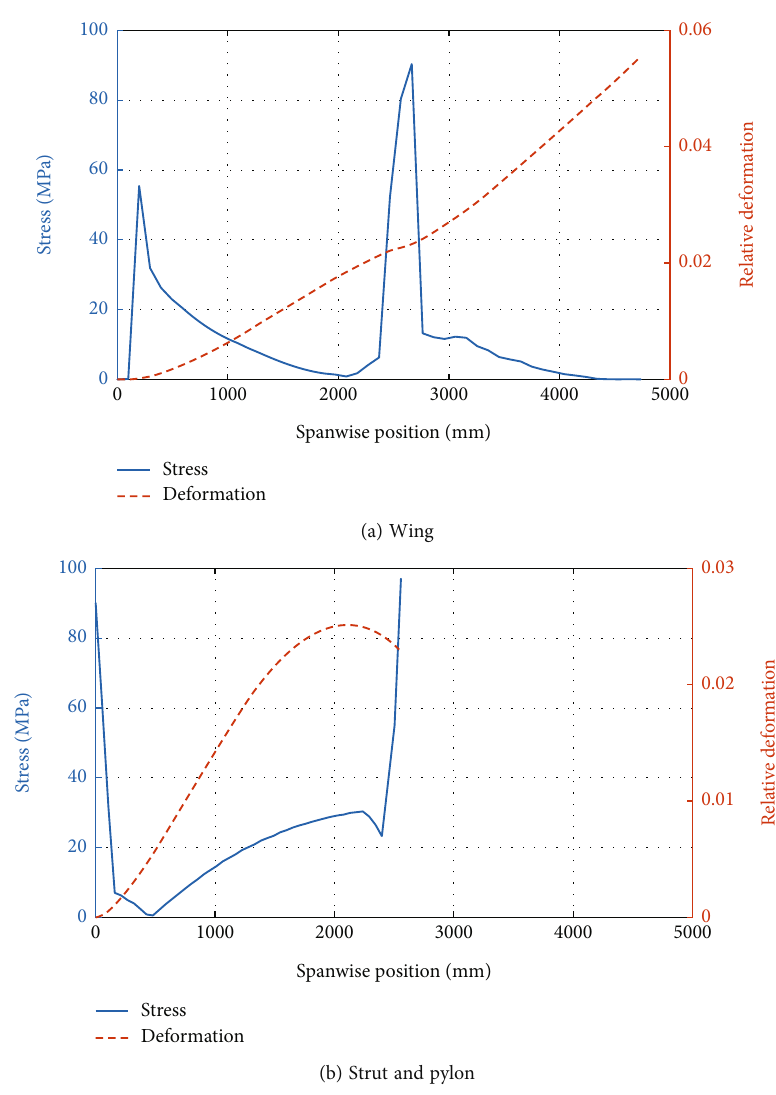
Figure 9: The distribution of stress and deformation along the spanwise direction. Table 5: Design